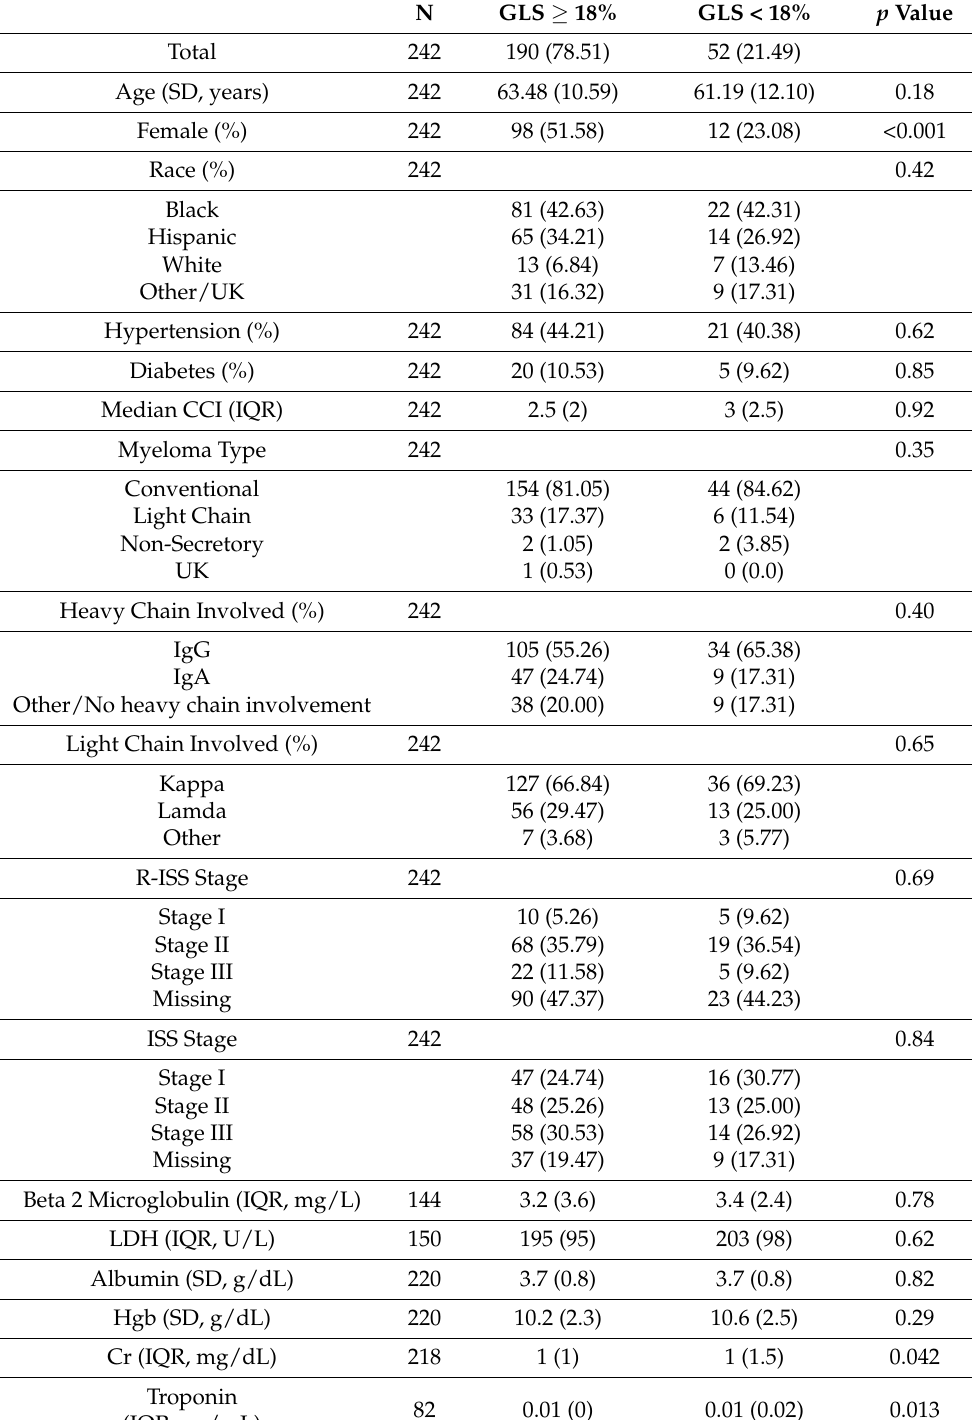
Table 1. Baseline demographics, comorbidities, MM, and lab